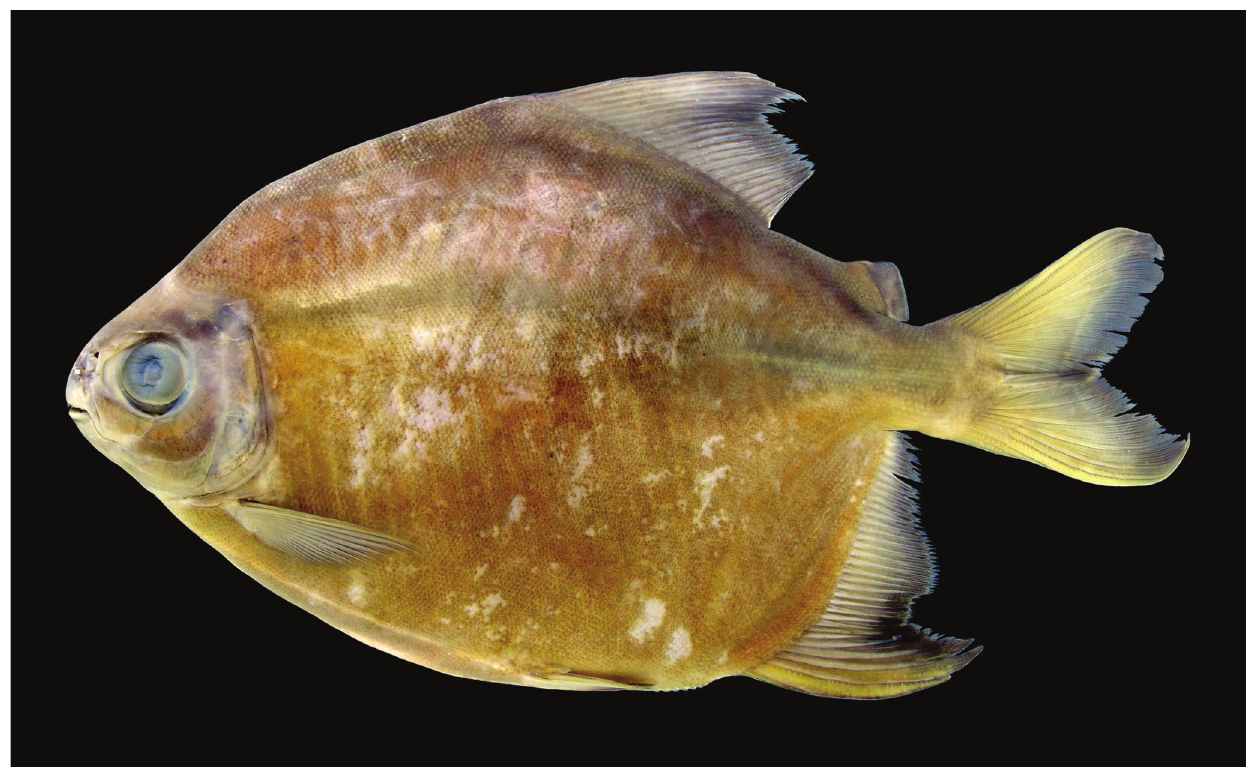
Fig. 1. Tometes camunani , MPEG 23447, holotype, mature male, 224.3 mm SL; Brazil, Pará, Oriximiná, Trombetas basin, rio Erepecuru, upstream of Cachoeira do